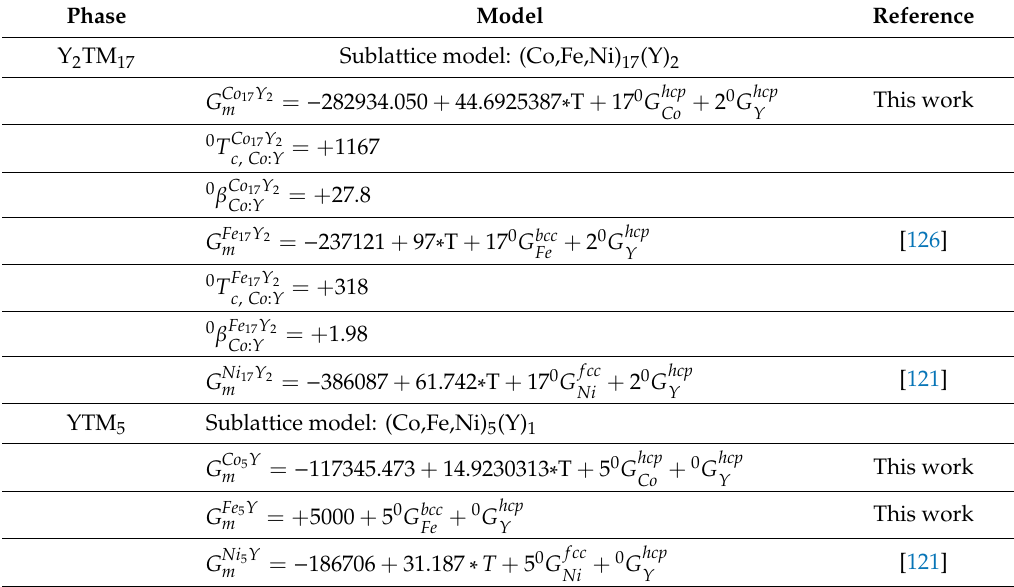
Table 2. Optimized thermodynamic parameters of Y 2 TM 17 and YTM 5 compounds with TM = Co, Fe, Ni (J /